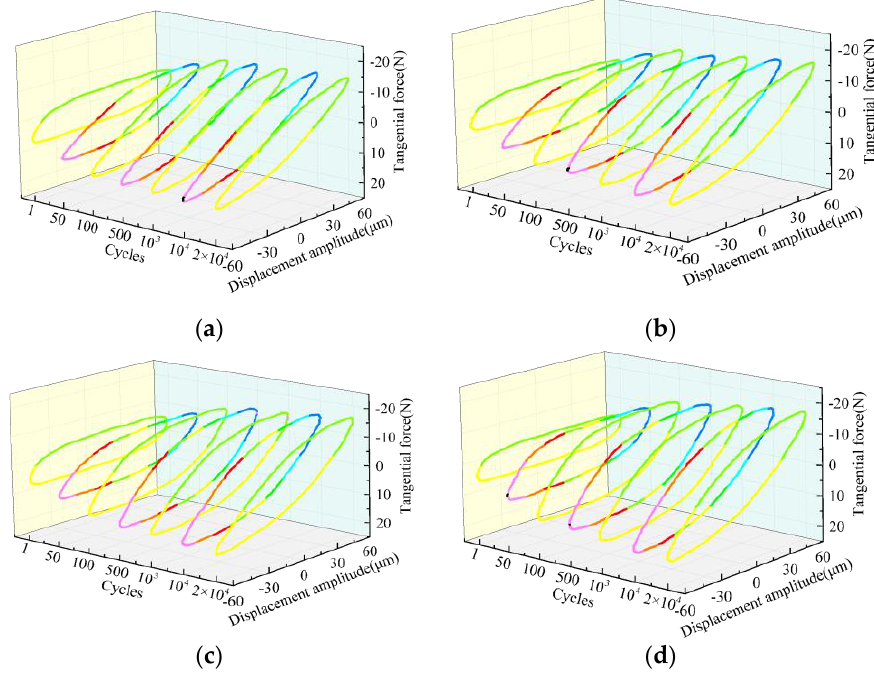
Figure 7 . Evolutions of hysteresis loops of tangential force versus displacement amplitude during tension–torsion cyclic loading of steel wires with fretting contact at different torsion angles. ( a ) θ = ±1°. ( b ) θ = ±1.5°. ( c ) θ = ±2°. ( d )θ = ±2.5°.